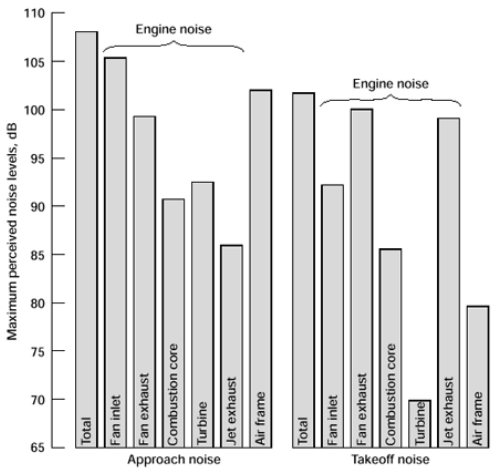
Figure 2. Typical distribution of aircraft noise between different sources during take-off and approach. Picture from